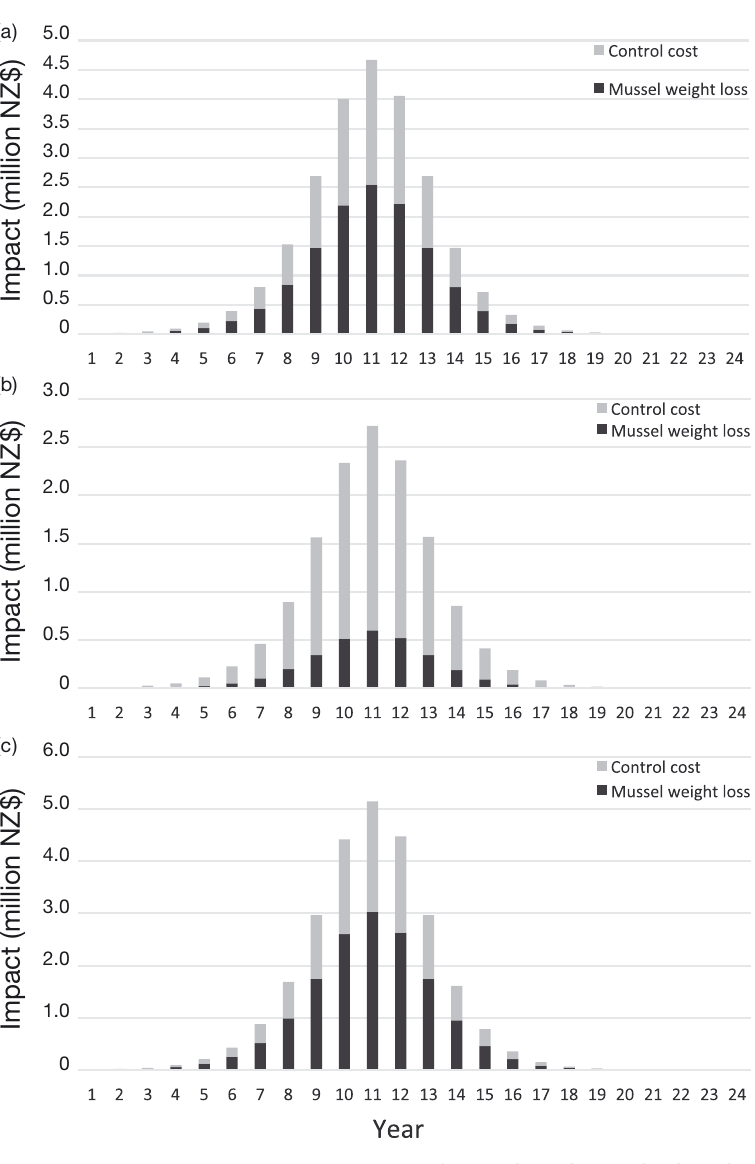
Fig. 3. Direct economic impacts on revenue of green-lipped mussel culture by (a) Styela clava , (b) Sabella spallanzanii and (c) both species per